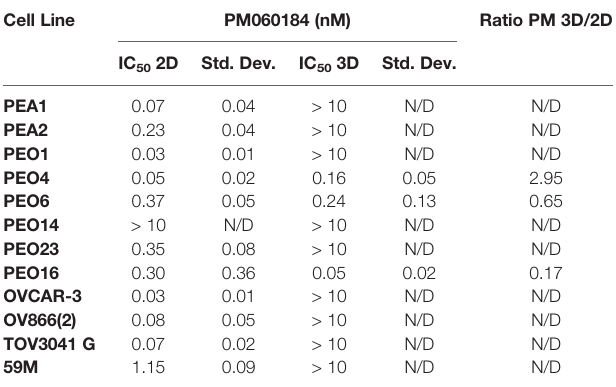
TABLE 2 | IC 50 values for plocabulin (PM060184) in 2D and 3D